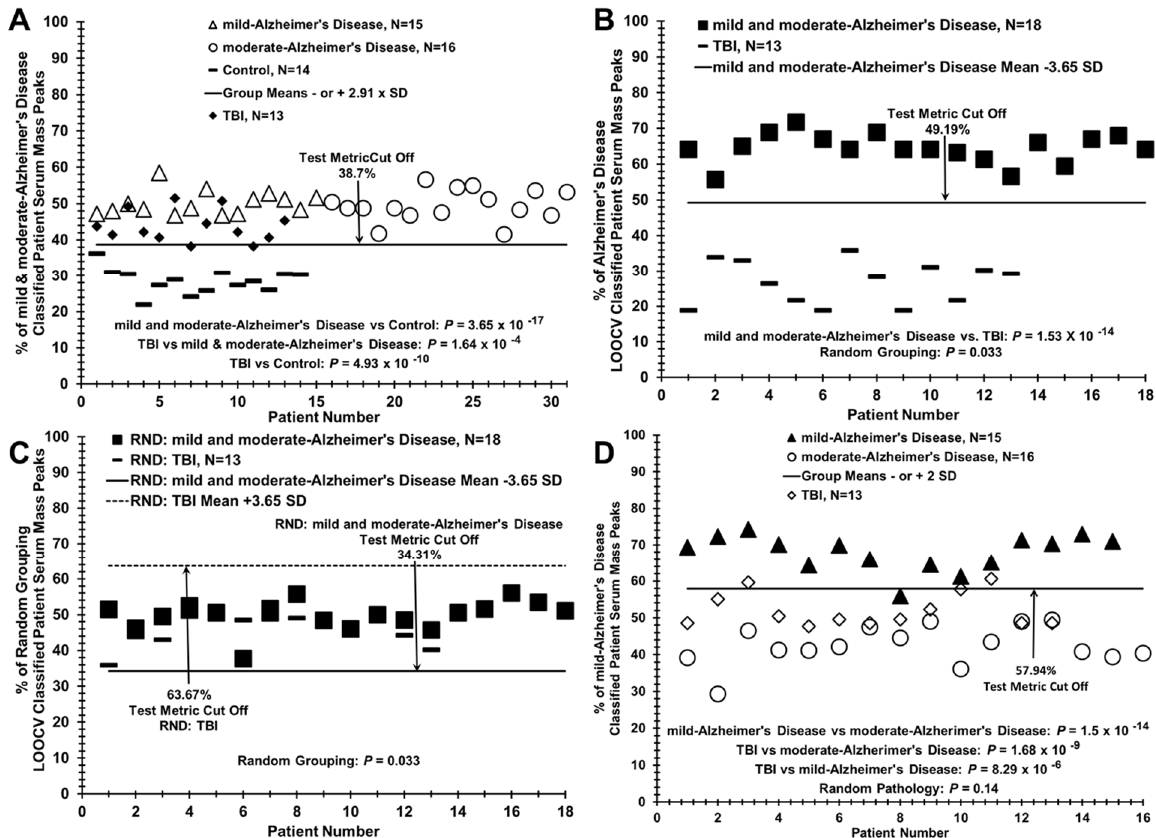
Figure 4. LOOCV/PCV procedure sequesters mild TBI patient sera with AD sera when compared to controls, and with moderate AD patient sera when compared to mild AD patient sera. ( A ) Sequestering of TBI patient sera ( N = 13, dark diamonds) with mild (open triangles) and moderate (open circles) AD patient sera versus controls (dashes). ( B ) Distinguishing mild and moderate AD patient sera (dark squares) from mild TBI patient sera (dashes) using LOOCV/PCV. ( C ) Randomization of sera samples between the two groups in panel B exhibiting loss of group discrimination. ( D ) Sequestering of TBI patient sera with moderate AD sera versus mild AD sera.